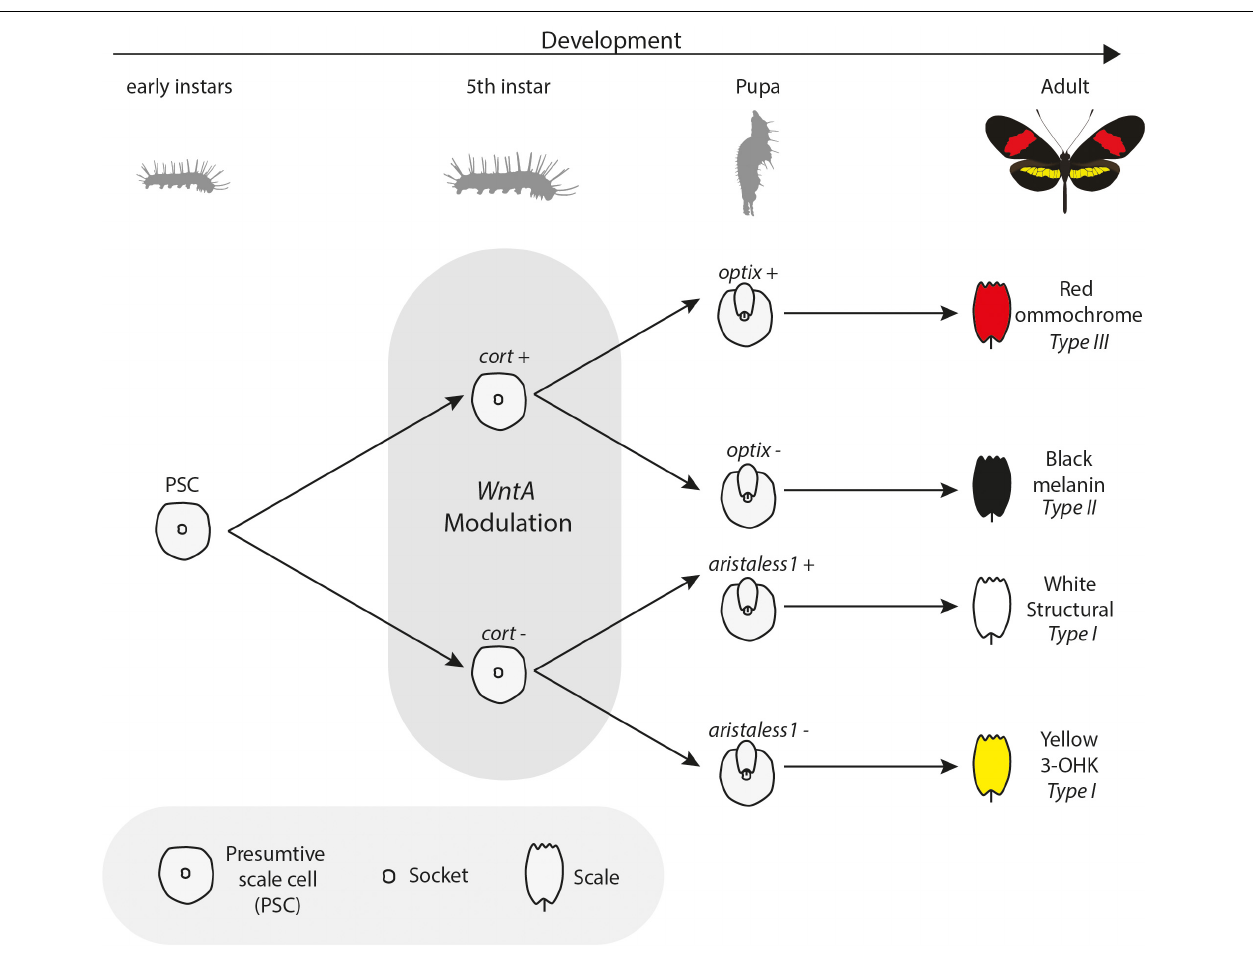
FIGURE 4 | Bifurcating model of interactions among color pattern loci: During wing development, scales express key effector genes that lead to alternate scale cell types. Early presumptive scale cells (PSCs) express cell specification genes such as cortex , which initiate differentiation into Type II ( optix − ) or Type III ( optix +) scales. In the absence of cortex , scale cells differentiate into Type I scales, which differ in pigmentation state based on 3-OHK synthesis controlled by aristaless1 expression. Under this model, WntA acts as a landscape modifier, whereby Wnt signaling modifies the trans environment experienced by differentiating scale cells, in turn delineating the boundaries in which specific differentiation factors can act. Model inspired by Larry Gilbert and collaborators (Gilbert et al.,